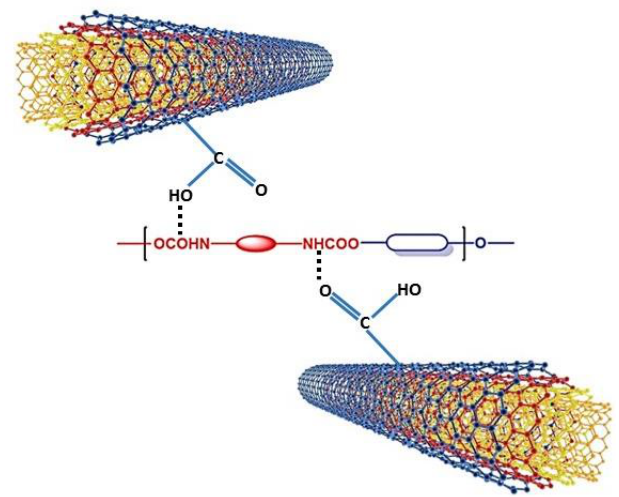
Figure 12. The most probable interaction exists via hydrogen bonding between COOH-functional- ized MWCNTs and PU matrix.